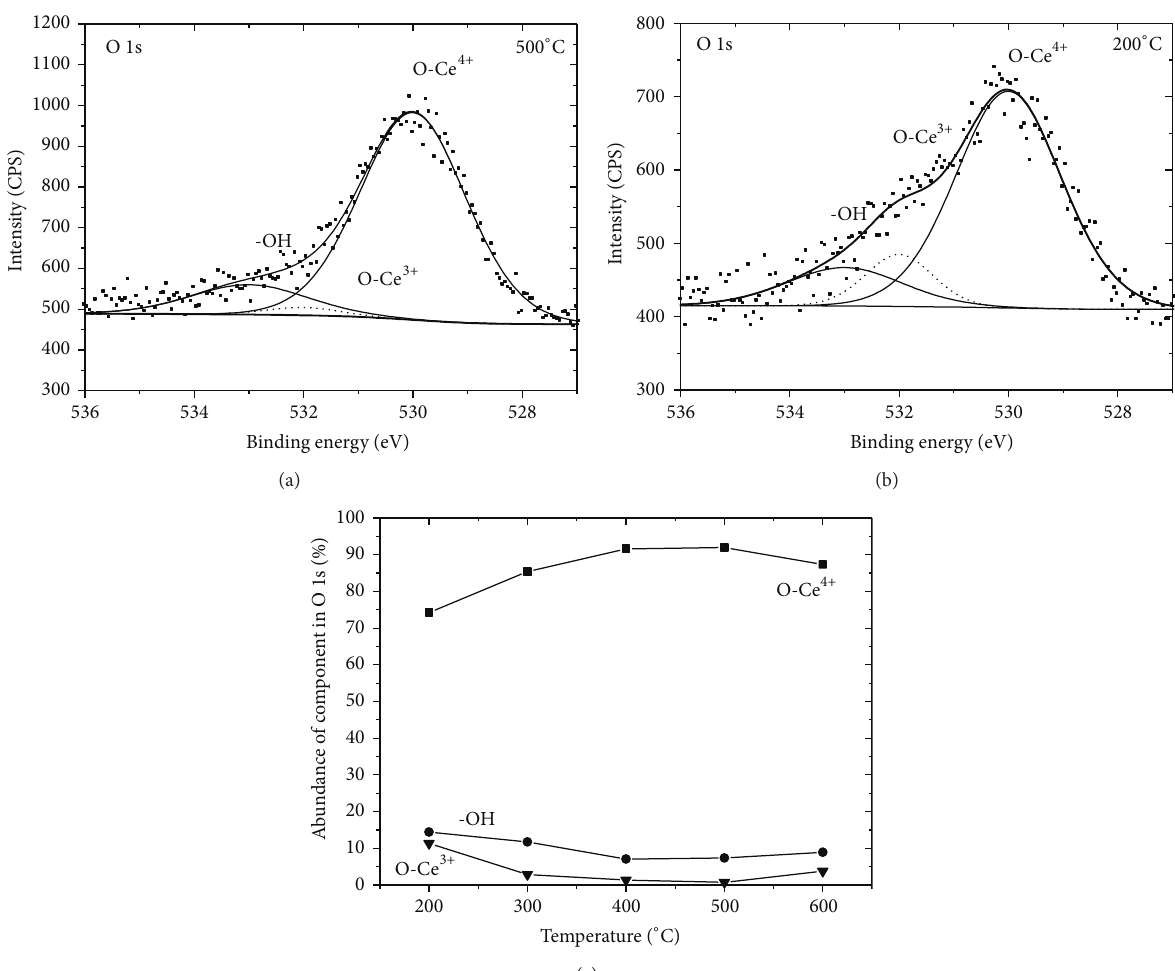
Figure 3: The oxygen O 1s peak with three deconvoluted components for the samples prepared at the calcination temperature of 500 ∘ C (a ) and 200 ∘ C (b); dependence of the abundances of O 1s components on the calcination temperature (c).